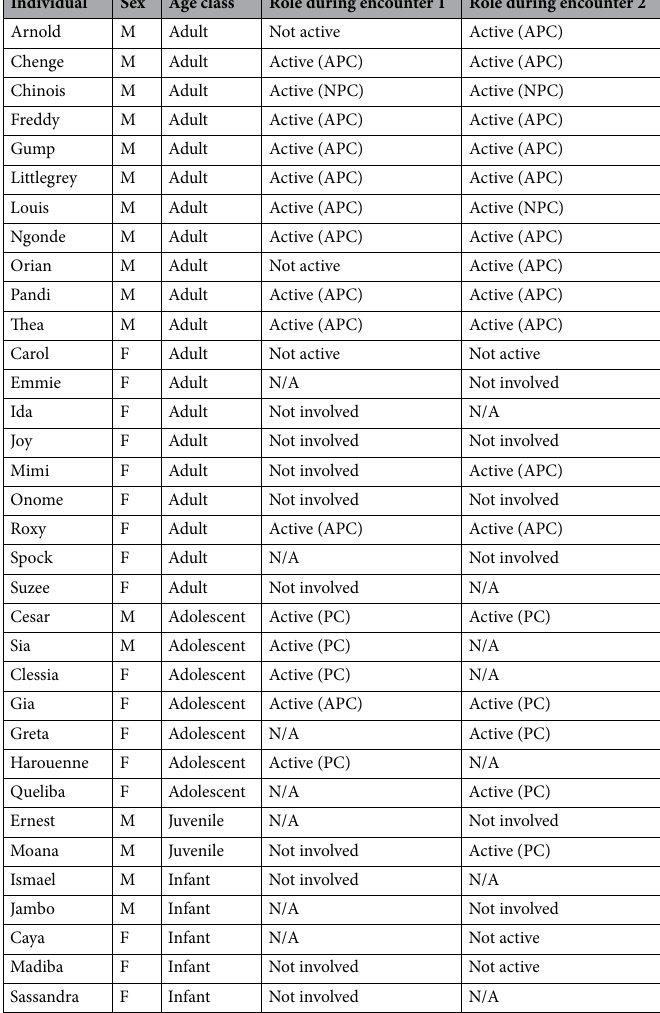
Table 1. Chimpanzees observed during the gorilla encounters. Members of the Rekambo chimpanzee community present during encounter 1 (N = 27) and encounter 2 (N = 27) as a function of name, sex (M = male; F = female), age class and role. The role describes the observed activity of individuals during the encounters: N/A not present, not involved seen only at the start and after the encounter, therefore their presence is inferred, not active observed during the encounter but no active role in the attack, active-no physical contact (NPC) active role in the attack (e.g. charging, chasing) but no direct contact with a gorilla, active- aggressive physical contact (APC) active role in the attack with direct aggressive behaviours towards a gorilla individual (e.g., hitting, biting, dragging), active-physical contact (PC) present throughout attack but direct contact only through handling of already deceased infant gorilla (e.g., touching, sniffing,